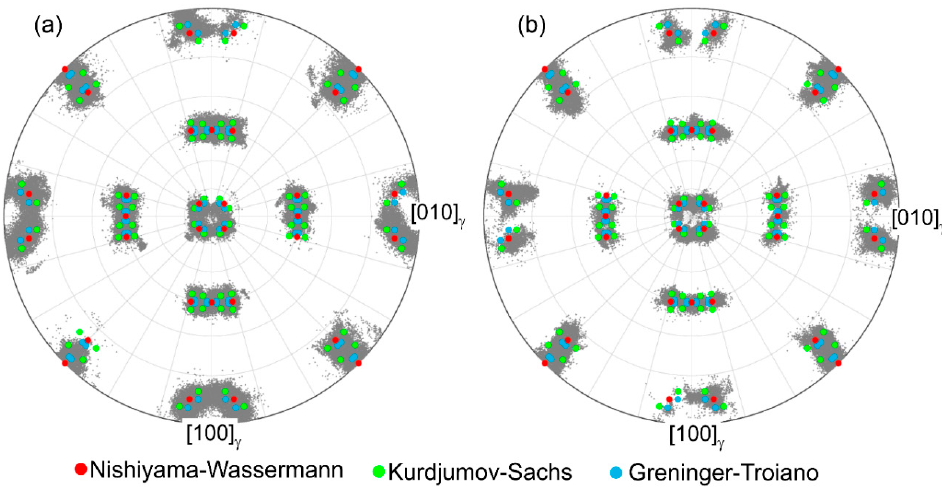
Figure 9. Martensite variant orientations presented as <100> α ’ pole figures in a <100> γ austenite standard projection. In addition to the experimental grey data clouds, the ORs of NW (red), GT (light blue), and KS (light green) are presented. ( a ) Lath martensite. ( b ) Plate martensite. For details see text.